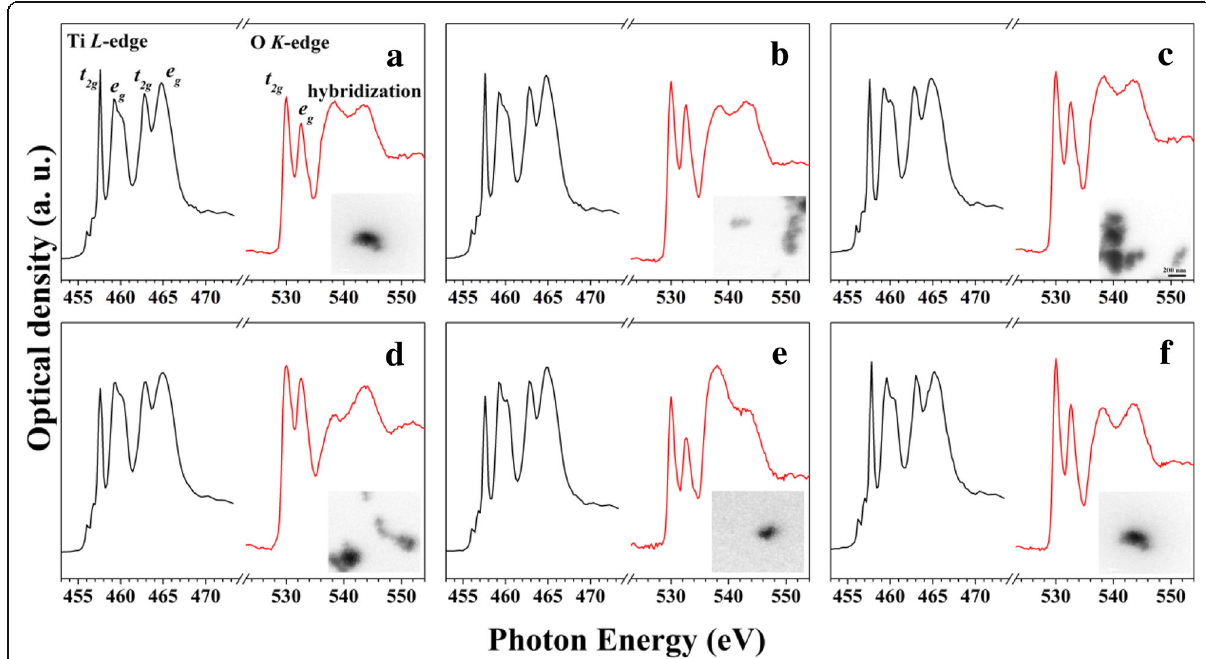
Fig. 1 XAS spectra (Ti L 2,3 -edge and O K -edge) and the corresponding stacked images for a anatase TiO 2 , b Cr-TiO 2 , c Mn-TiO 2 , d Fe-TiO 2 , e Co-TiO 2 , and f Ni-TiO 2 (5 mol% TM-TiO 2 NPs). The stacked image size is 1 μ m × 1 μ m (scale bar is 200